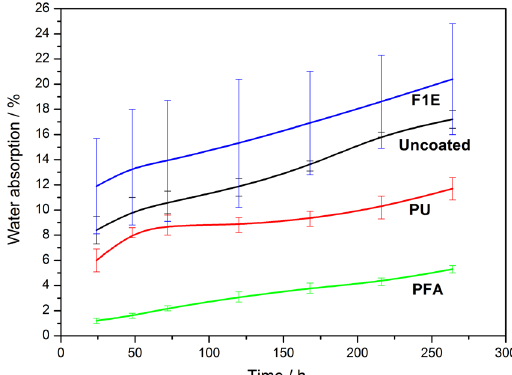
Figure 2. Water absorption behaviour of flax/phenolic laminates coated with different bio-based